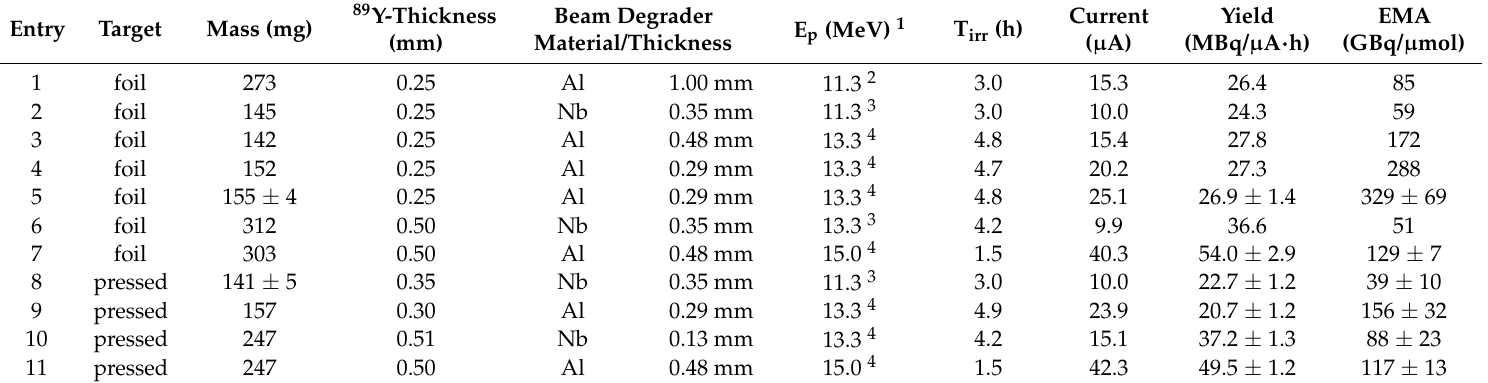
Table 2. Targets characteristics, measured production yields and effective molar activity